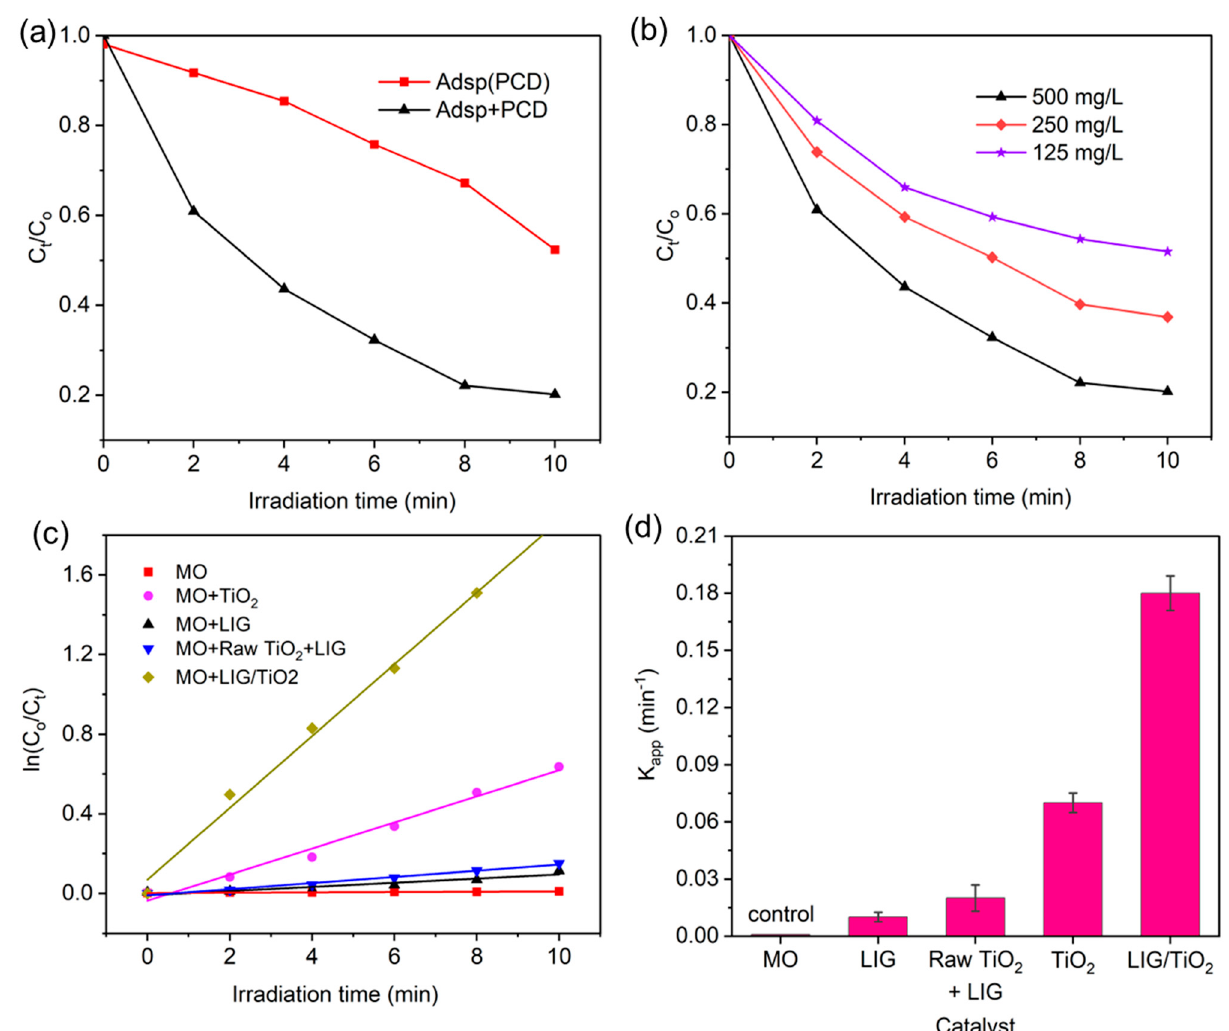
Figure 7. ( a ) Adsorption enhanced the photocatalytic degradation, Adsp(PCD) = adsorption and photocatalysis started both at same time (t = 0 min), Adsp + PCD = solution reaches adsorption- desorption equilibrium after 3 h, and then the photocatalysis degradation was initiated; ( b ) effect of increasing the dose of the catalyst on removal efficiency; ( c ) first order kinetics of methyl orange dye degradation for C o = 20 mg/L, catalyst dose = 500 mg/L, T = 298 K, P = 1 atm.; ( d ) first order apparent kinetic constants of different catalysts.